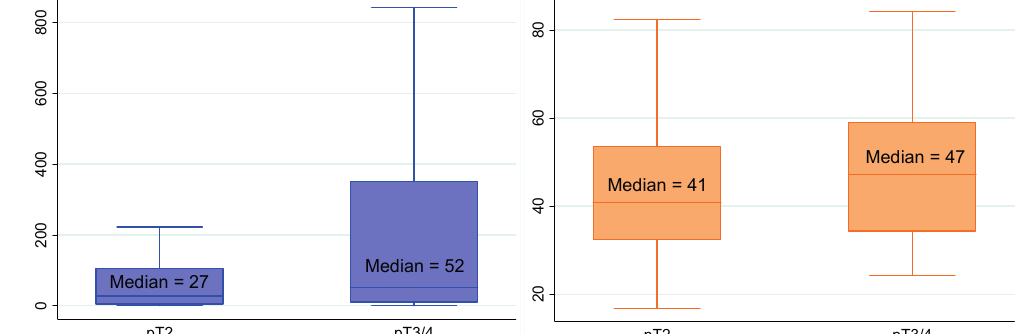
Figure 3. Median T2 score ( p = 0.027) and PHI ( p = 0.086) according to extracapsular extension. Biological and pathological findings in 154 men who underwent radical prostatectomies for prostate cancer. (See the note in the legend of the Figure 1 for complete explanation of how to read the